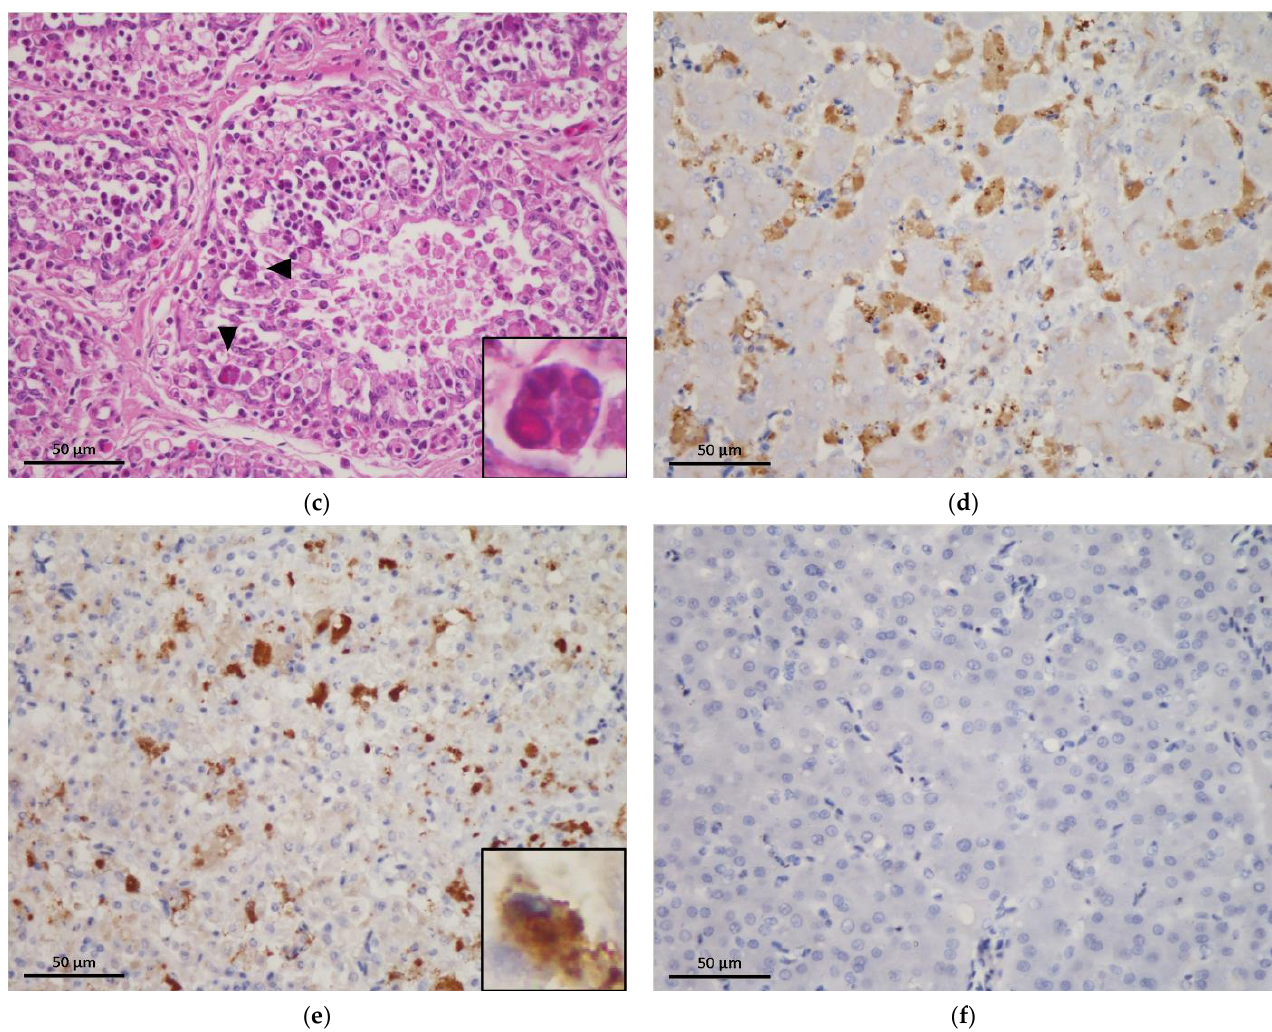
Figure 1. The result of histopathological examination and immunohistochemical (IHC) staining. ( a ) In the liver, there are various numbers of intracytoplasmic basophilic punctate organisms in the hepatocytes and macrophages (arrowheads); H&E stain, × 400. ( b ) Intracytoplasmic basophilic punctate organisms distributed in splenic macrophages (arrowheads); H&E stain, × 400. ( c ) Large botryoid inclusion bodies (indicated by the arrowheads) within the cytoplasm of macrophages in the bursa of Fabricius with lymphoid depletion; H&E stain, × 400. ( d , e ) Strong Chlamydia -positive signals detected within the cytoplasm of macrophages in the liver and spleen, respectively; IHC stain, × 400. ( f ) A liver section of a PCR-negative case subjected to IHC staining; IHC stain, × 400. The insets in panels ( a ) to ( e ) show infected cells under × 1000